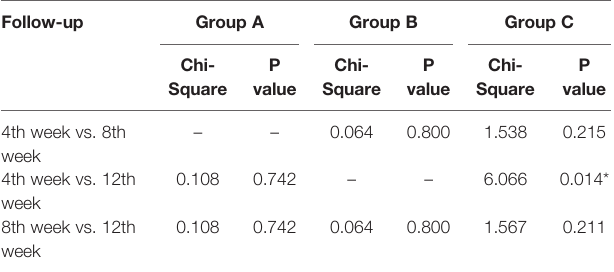
TABLE 4 | The differences of chi-square statistical outcome in percentage of MCID cases between each two various follow-up points. Follow-up